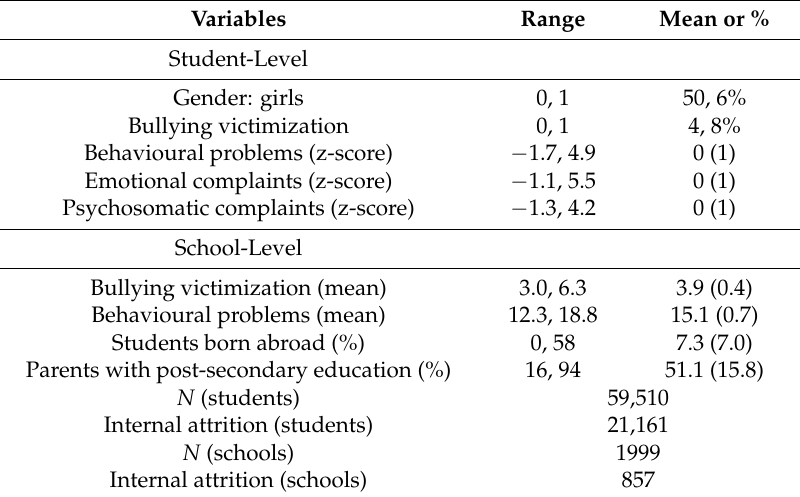
Table 1. Descriptive statistics for student- and school-level variables.